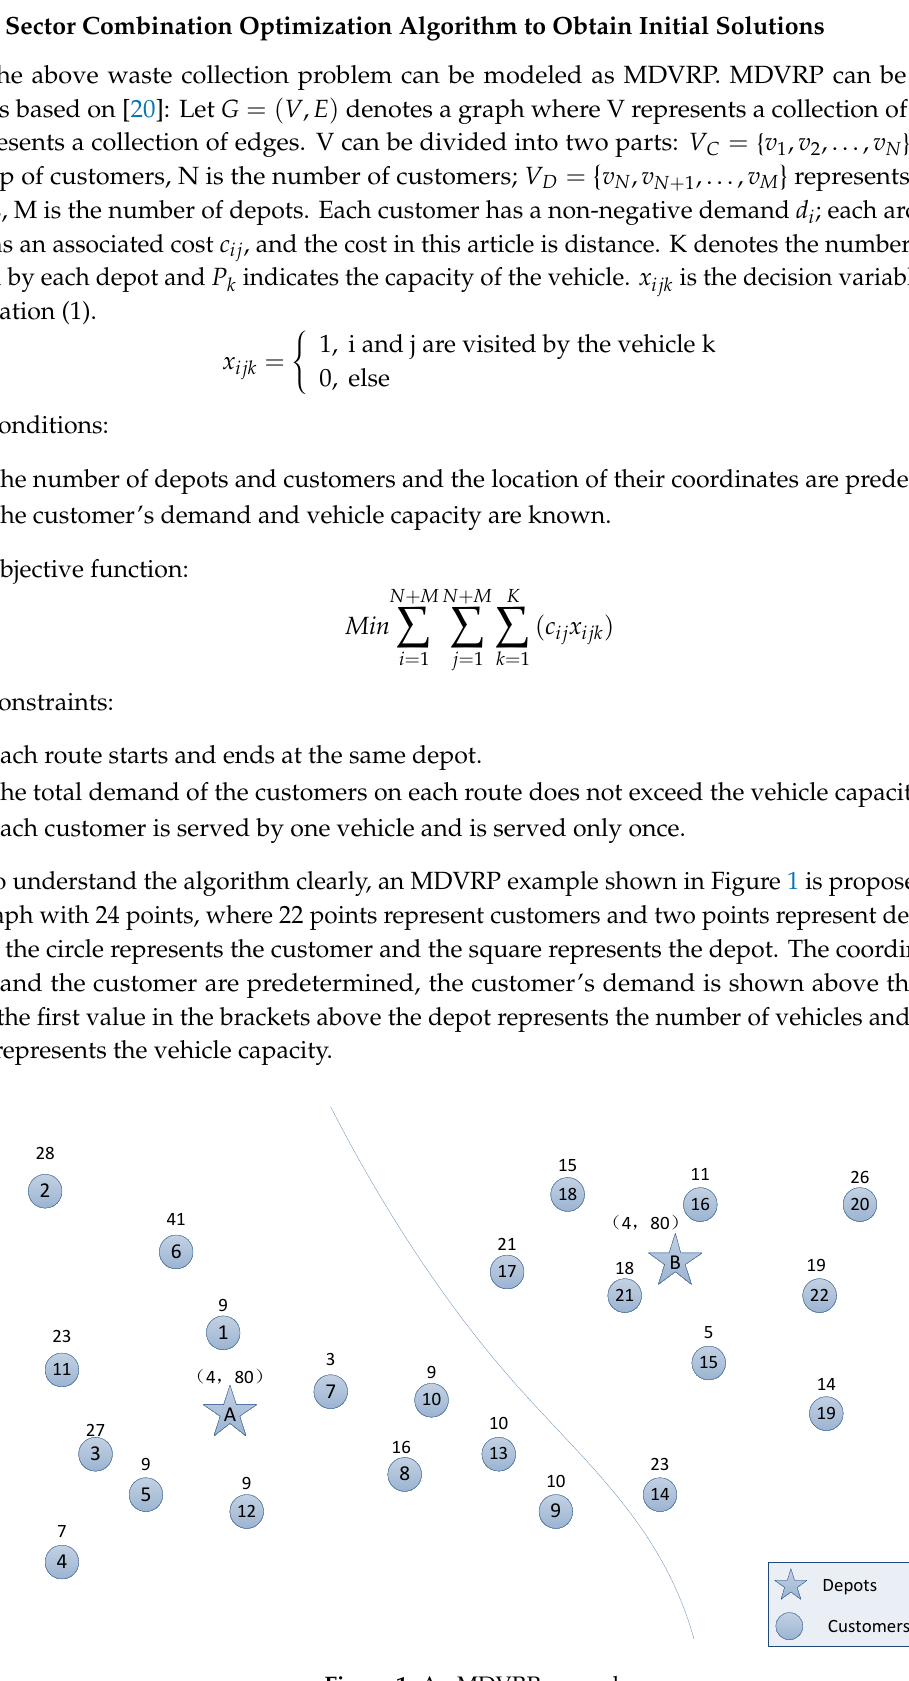
Figure 1. An MDVRP Figure 1. An MDVRP example.